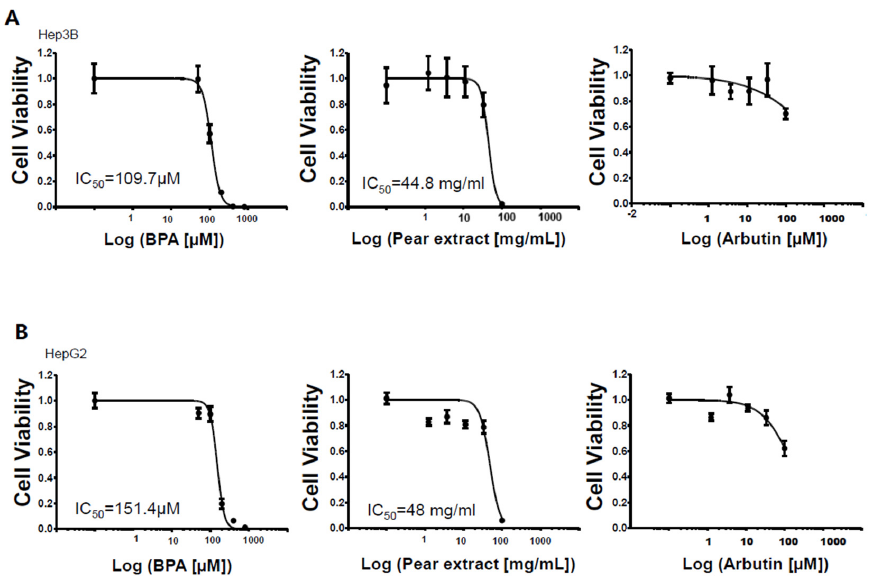
Figure 3. Dose response curves of BPA, Korean pear extract, and arbutin against human liver cells: ( A ) Hep3B cells and ( B ) HepG2 cells.